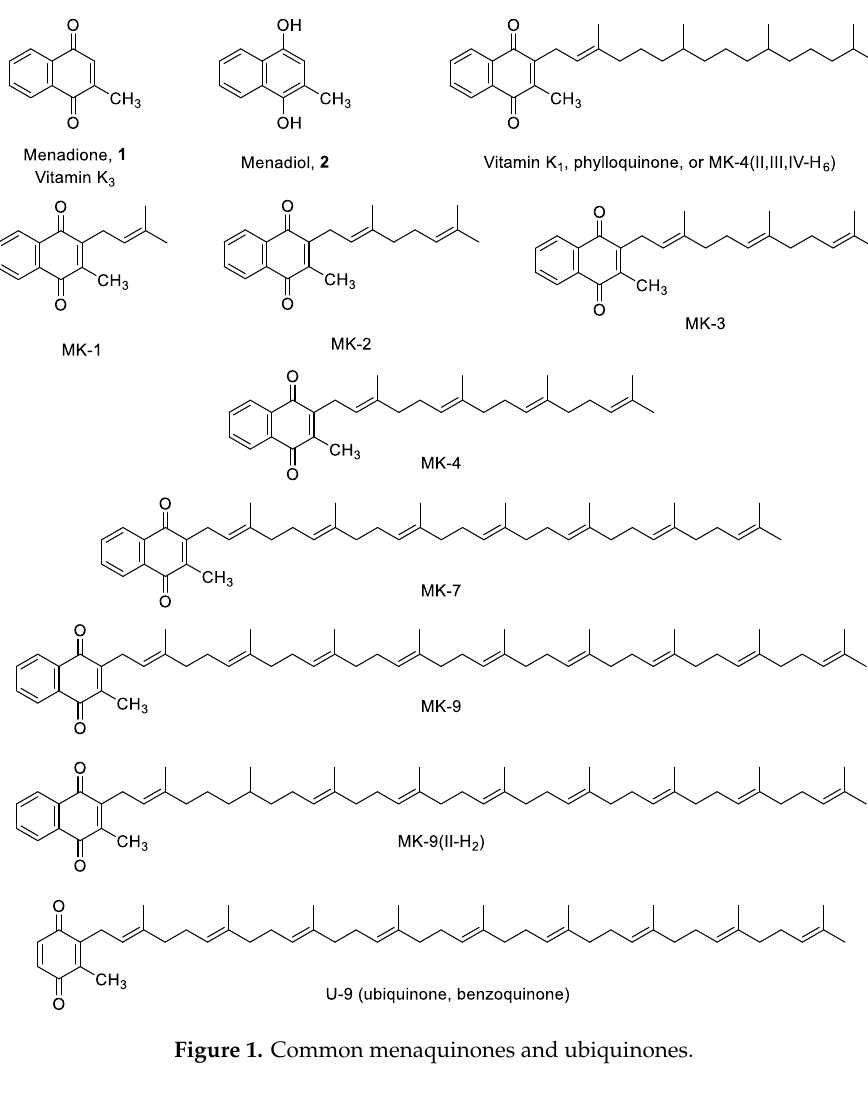
Figure 1. Common menaquinones and ubiquinones.